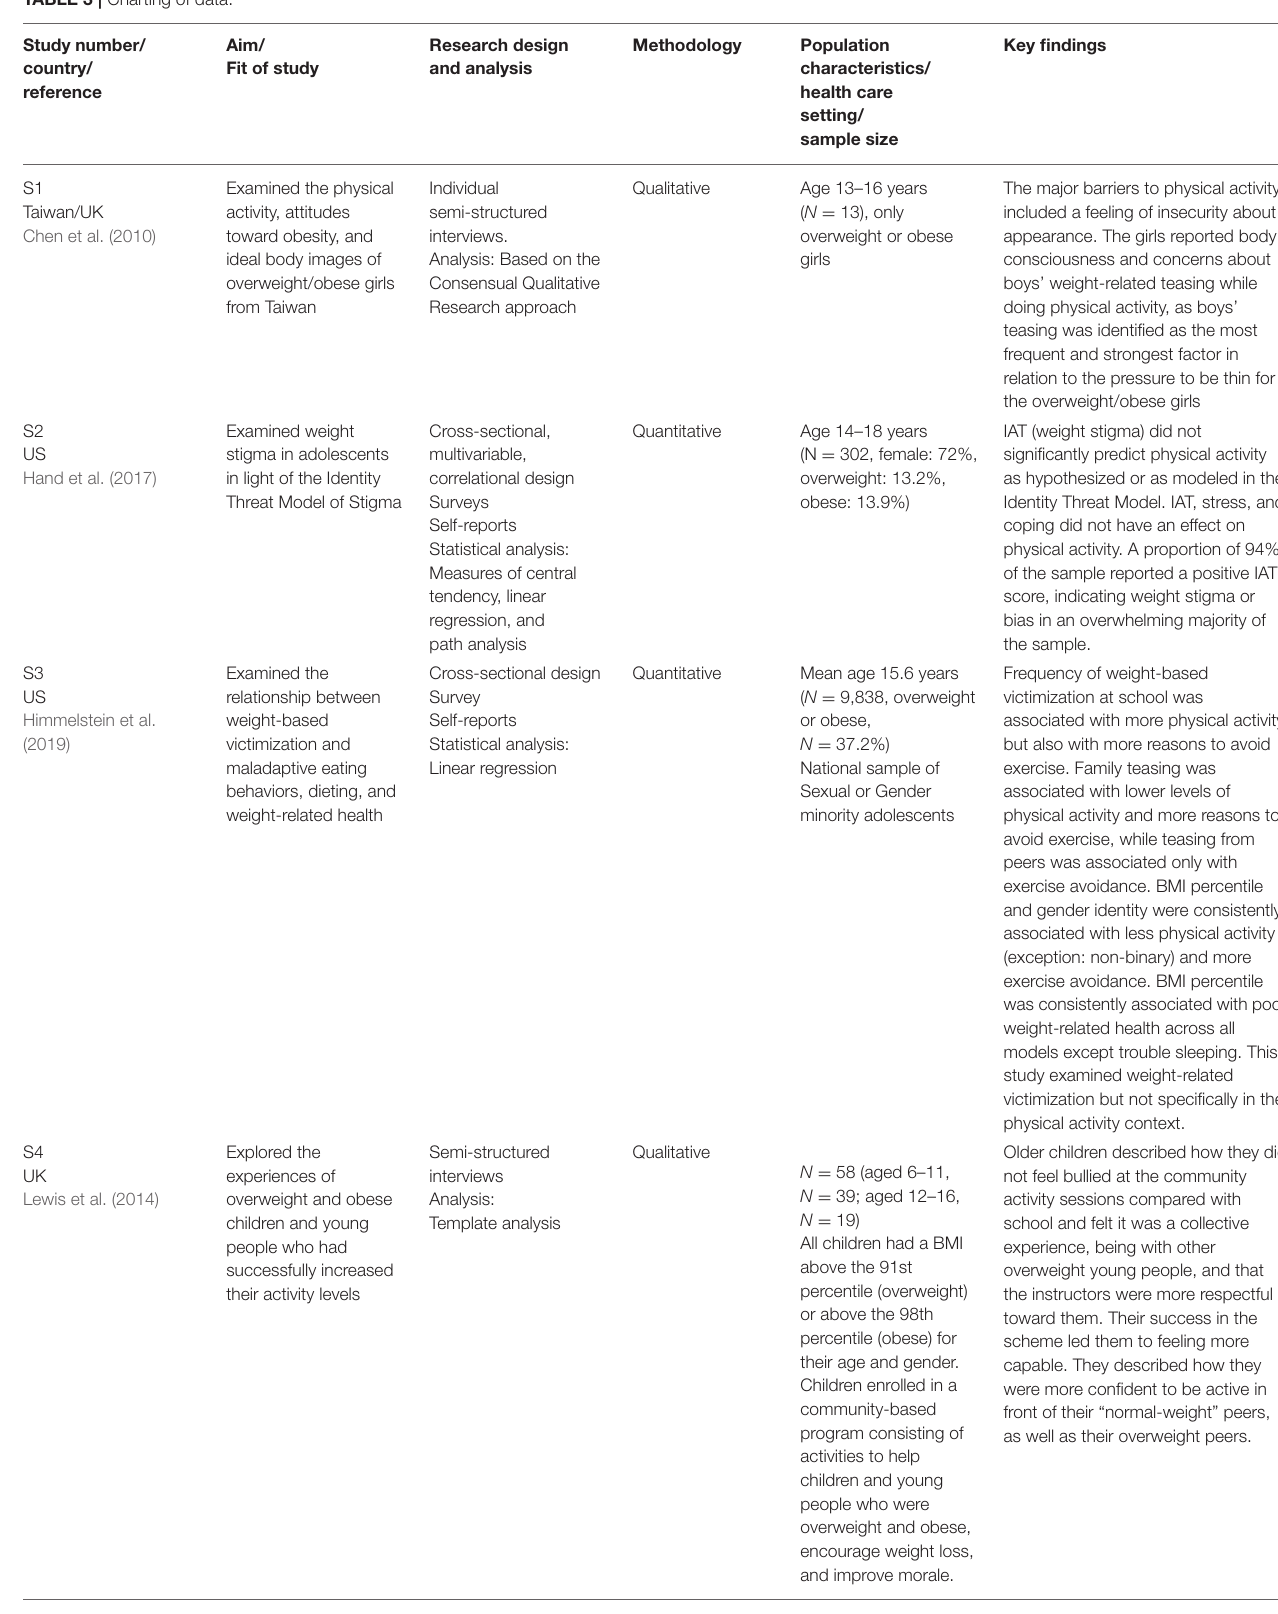
TABLE 3 | Charting of